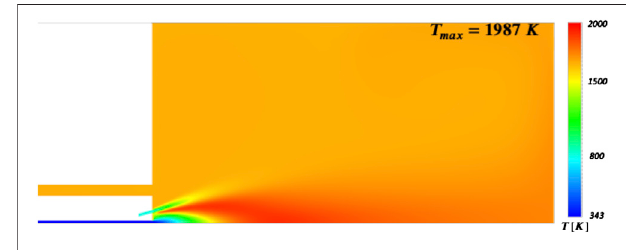
FIGURE 9 | Case 11 (70% H 2 ) temperature contour. The tilting of the air inlets does not produce the desired effect.